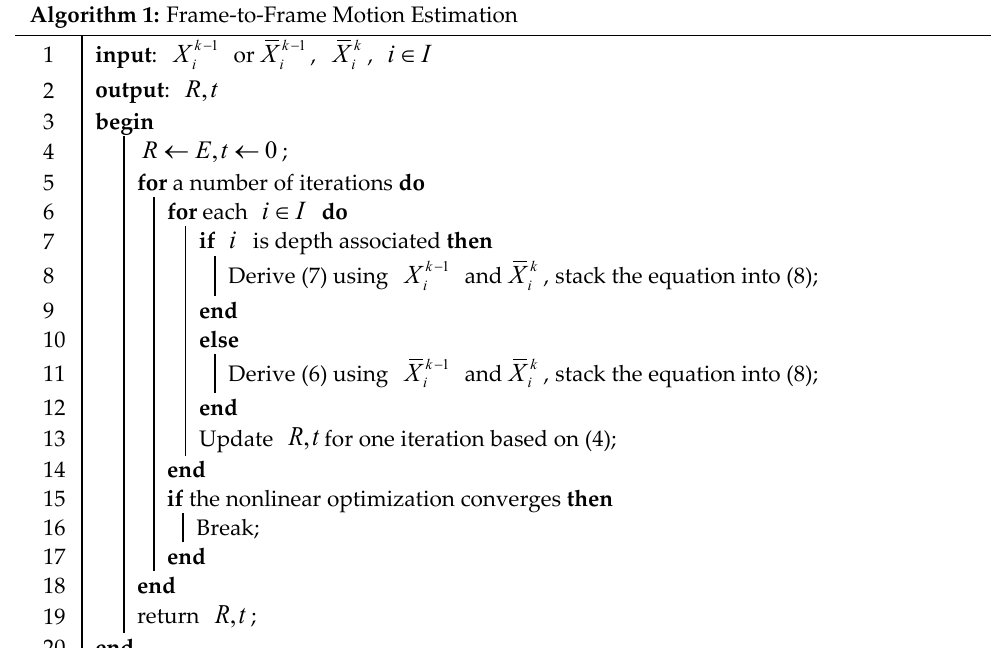
Algorithm 1: Frame-to-Frame Motion Estimation